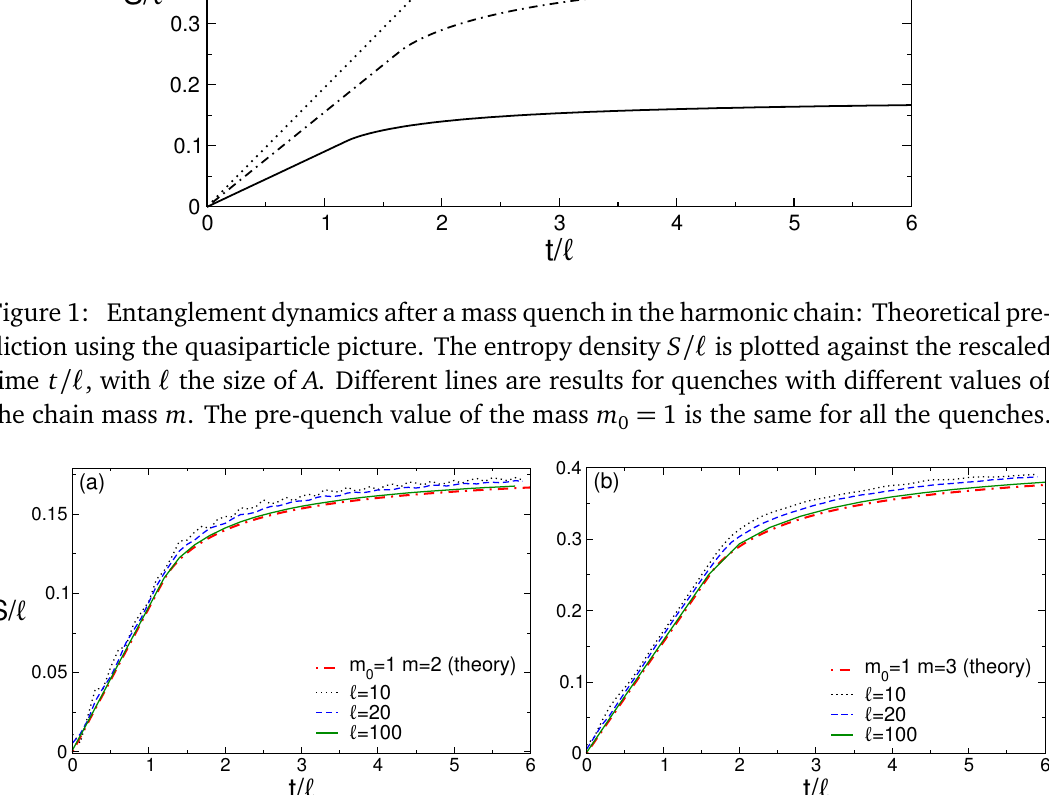
Figure 2: Entanglement dynamics after a mass quench in the harmonic chain: Comparison between the quasiparticle picture and finite-chain results. In both panels the entropy density S /(cid:96) is plotted against the rescaled time t /(cid:96) , with (cid:96) the size of A . Panels (a) and (b) show results for the quenches with final mass m = 2 and m = 3, respectively. The pre-quench value of the = 1. In both panels dotted, dashed, and continuous lines are finite-size results for mass is m 0 a chain with L = 1000 sites and subsystem sizes (cid:96) = 10,20,100. The dashed-dotted line is the prediction obtained using the quasiparticle picture in the space-time scaling